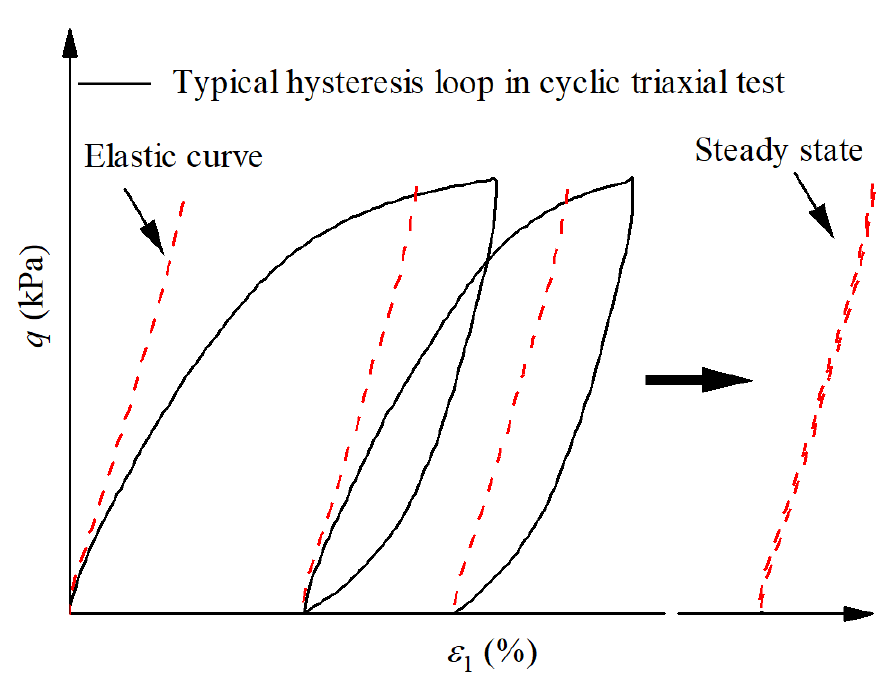
Figure 2. Sketch of determining elastic curve for each stress cycle .